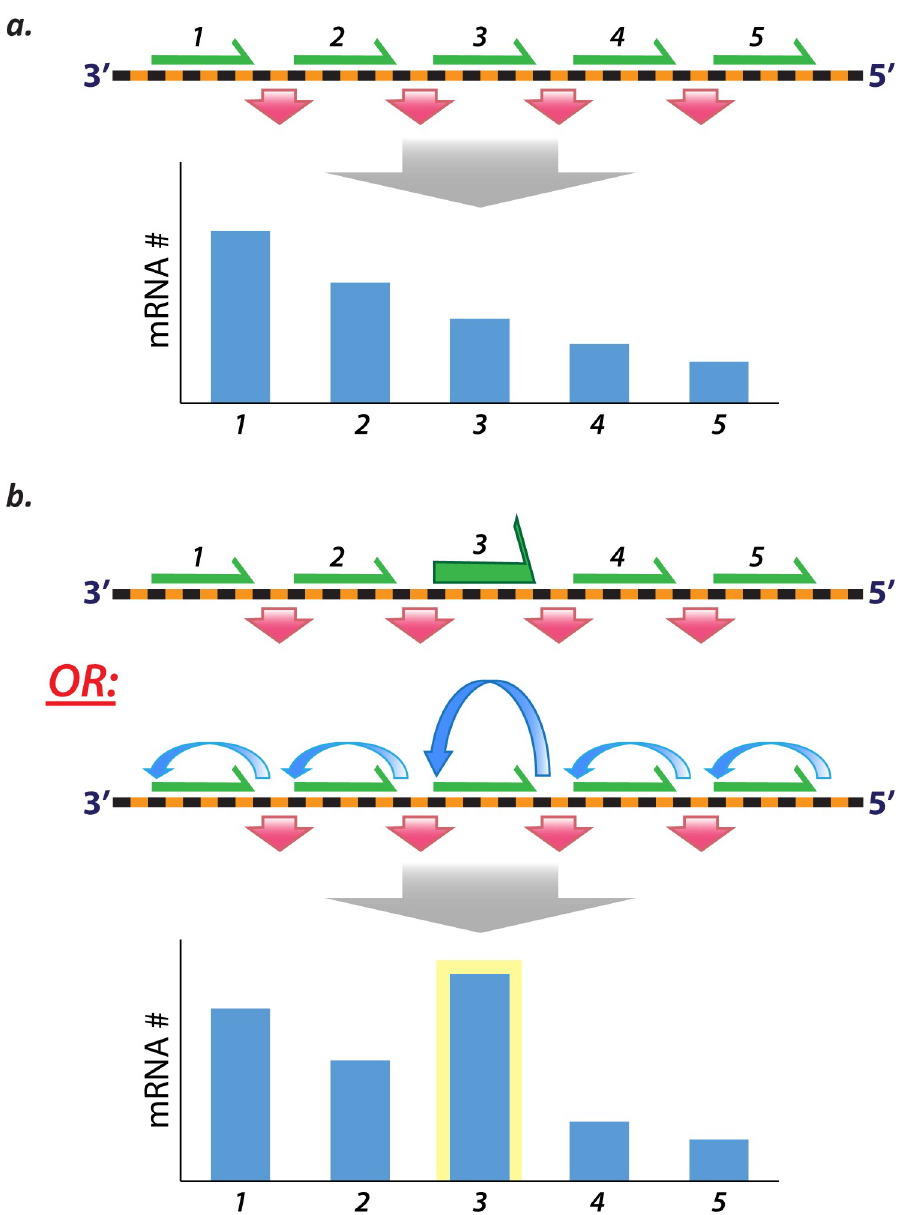
Fig 6. Non-gradient transcription requires novel models of RSV transcription. (a) The hitherto widely accepted model of RSV (and all NSV) transcription involves sequential transcription from the 3’ promoter and transcriptional attenuation at gene junctions. Shown in black and orange is a cartoon representation of an idealized NSV genome. The green arrows represent equal probabilities of transcription at each of five genes, and the red arrows represent equal attenuation of transcription at each gene junction. Combined with sequential transcription, equal probabilities of transcription and equal rates of attenuation (and assuming equal transcript stabilities) result in a gradient of mRNA levels (shown as a plot depicting decreasing levels of mRNA from genes 1 to 5). (b) Non-gradient RSV transcription requires alternative models. Two such models incorporate either 1) transcription of variable probability (top cartoon– see green arrow of increased size indicating a higher probability of transcription at gene 3) and/or 2) polymerase recycling (bottom cartoon–see blue arrows indicating successive rounds of transcription of the same gene, with gene 3 supporting more rounds of transcription). Transcription of variable probability at different genes is supported by published data showing varied effects of different cis-acting sequences on gene expression. Polymerase recycling describes the repeated transcription of a single gene by one or more polymerases before proceeding to a downstream gene. Polymerase recycling would require polymerase scanning, which is well established, and potentially a mechanism to bias polymerase scanning away from the next downstream GS signal and back toward the upstream GS